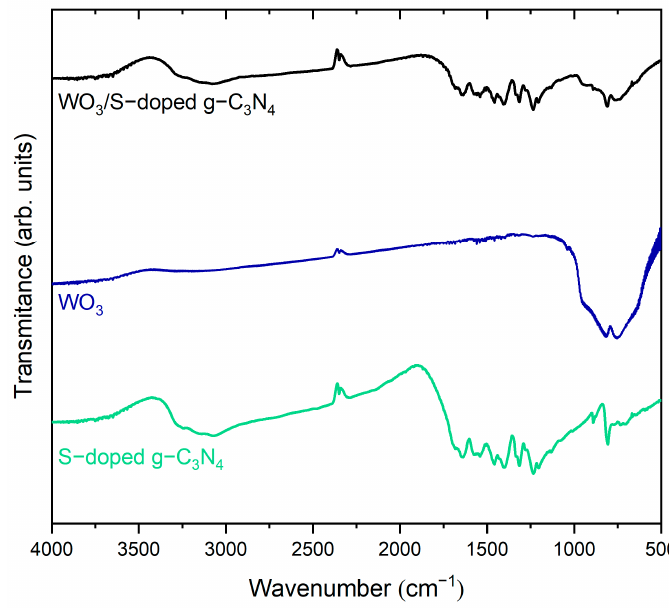
Figure 3. FTIR spectra of WO 3 /S-g-C 3 N 4 and single components.